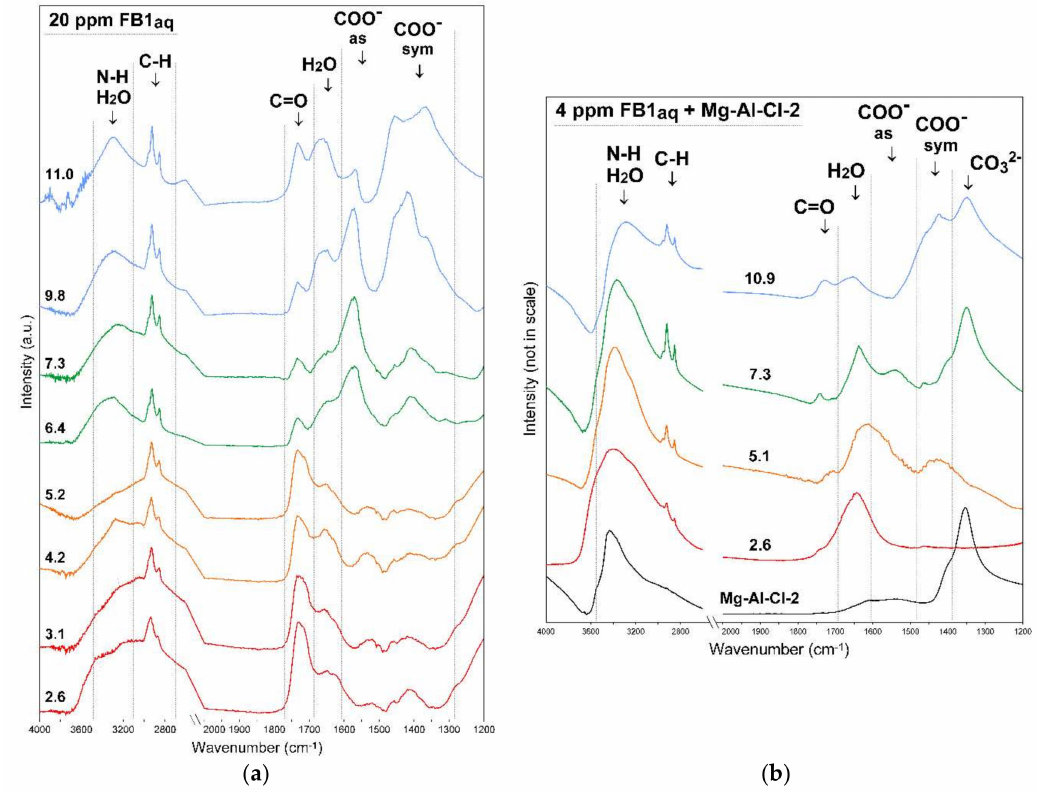
Figure 11. FTIR spectra of: ( a ) FB1 versus pH (C FB1 20 ppm) and ( b ) FB1-treated Mg-Al-Cl-2 sample versus pH (C FB1 4 ppm). The values on the graphs indicate equilibrium